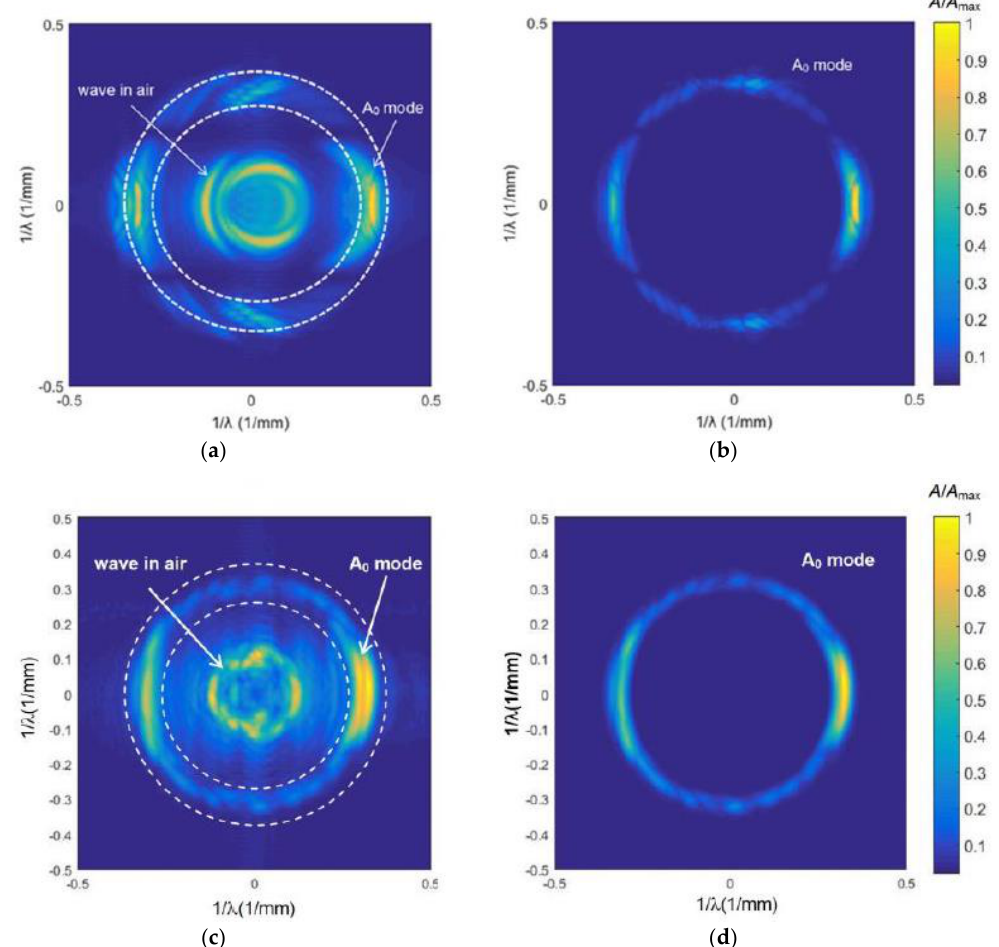
Figure 19. The 3D spectra of the simulated ( a , b ) and measured ( c , d ) ultrasonic fields: ( a ) before 3D filtering; ( b ) after 3D filtering; ( c ) before 3D filtering; and ( d ) after 3D filtering. The presented amplitude values shown in the color bar were normalized with respect to the maximum value in the field.